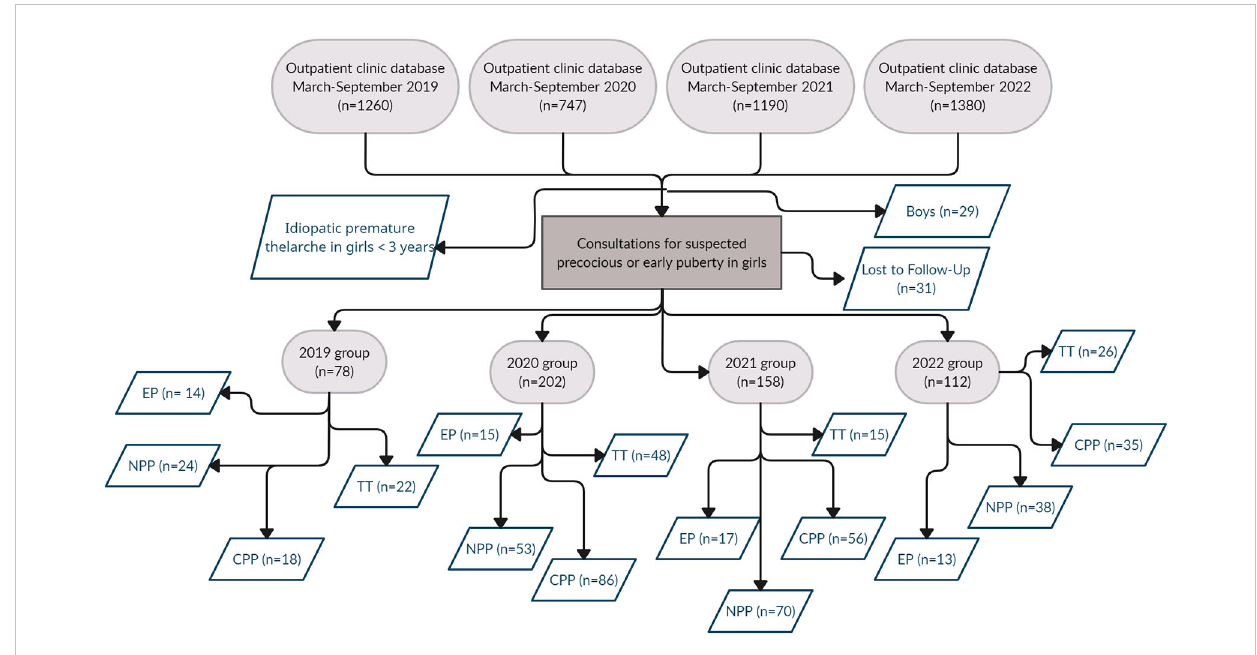
FIGURE 1 Flowchart summarizing the study